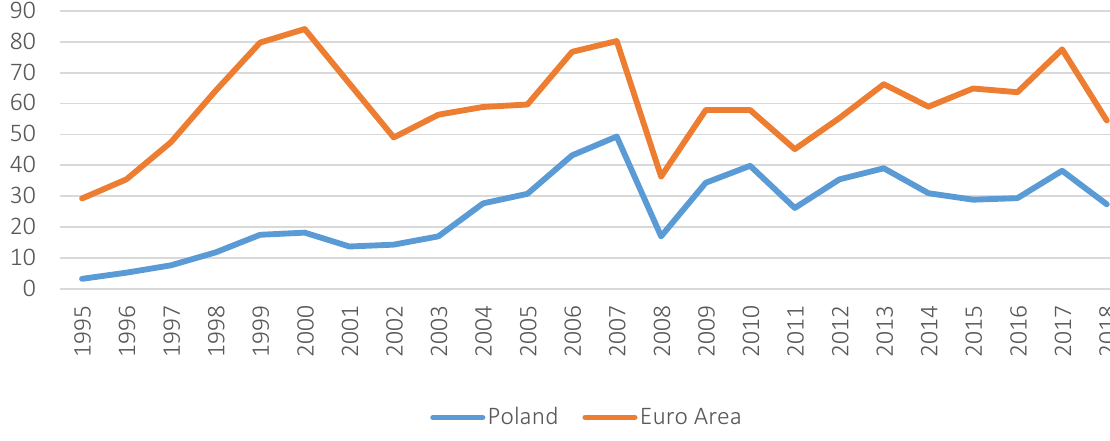
Figure 3. Market capitalization of listed domestic companies (% of